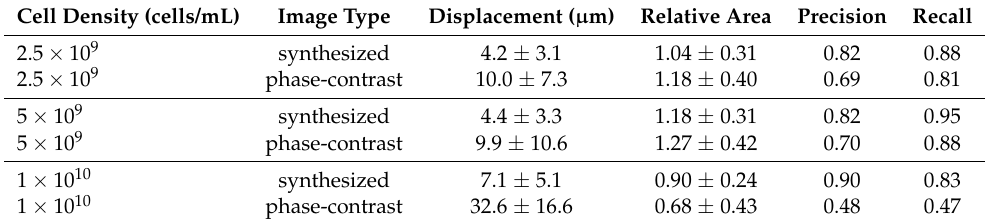
Table 3. Segmentation accuracy for individual